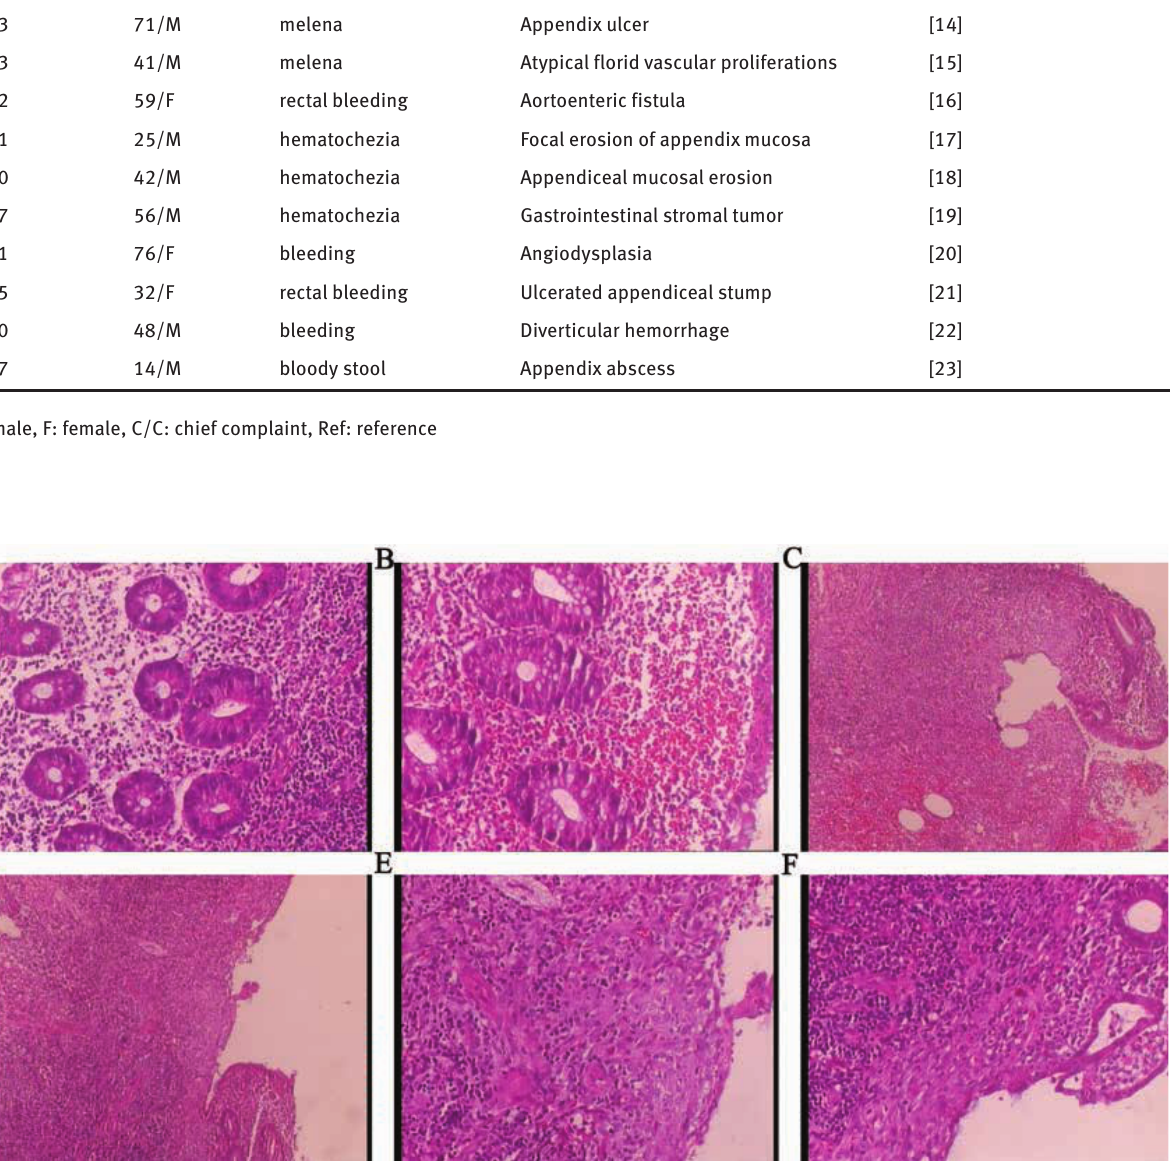
Clinical impression